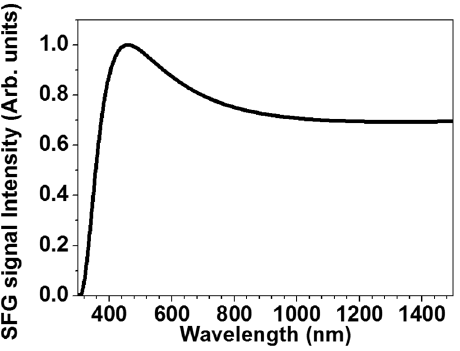
Figure 2. Phase matching curve when a type I 5 μm BBO crystal is used and an 800 nm pulse is used as a reference